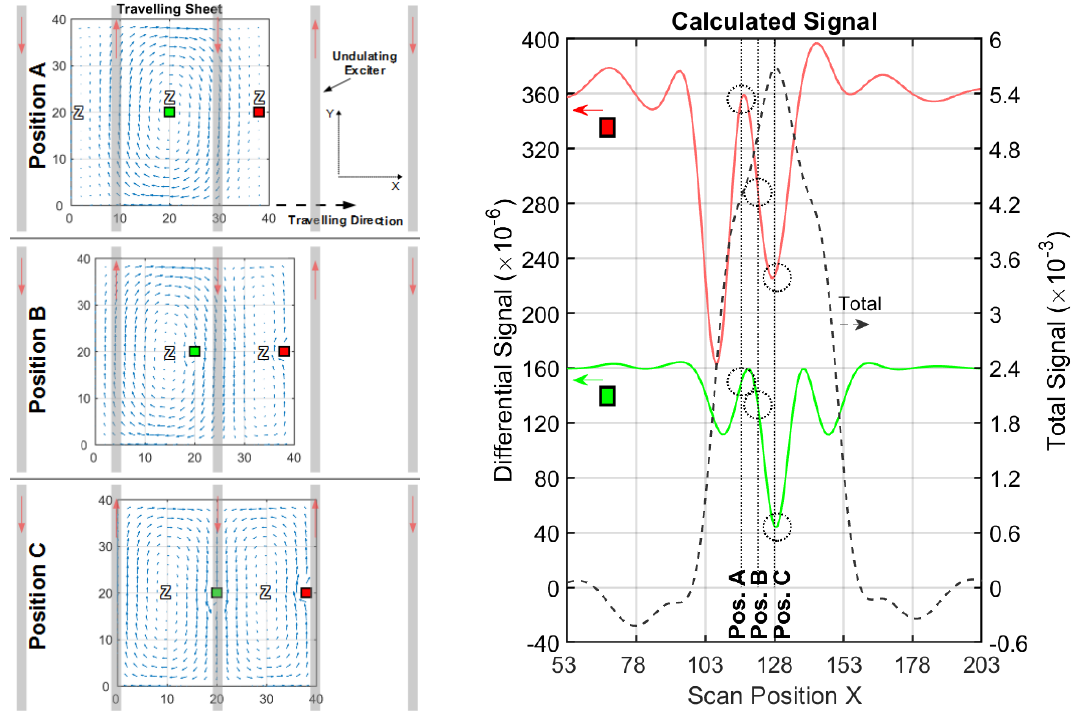
Figure 8. Current and signal calculations with an undulator setup (cf. Figure 3c); (left) Travelling 2D sheet with local voids (green and red) in front of an undulator. Blue arrows depict the current direction and intensity. Only three significant x-positions (A, B and C) are shown; (right) Total (dotted black) and differential signals for a void in the center (green) and for a void at the edge (red). T able 3. The main results from the calculated signals, shown in Figure 8.